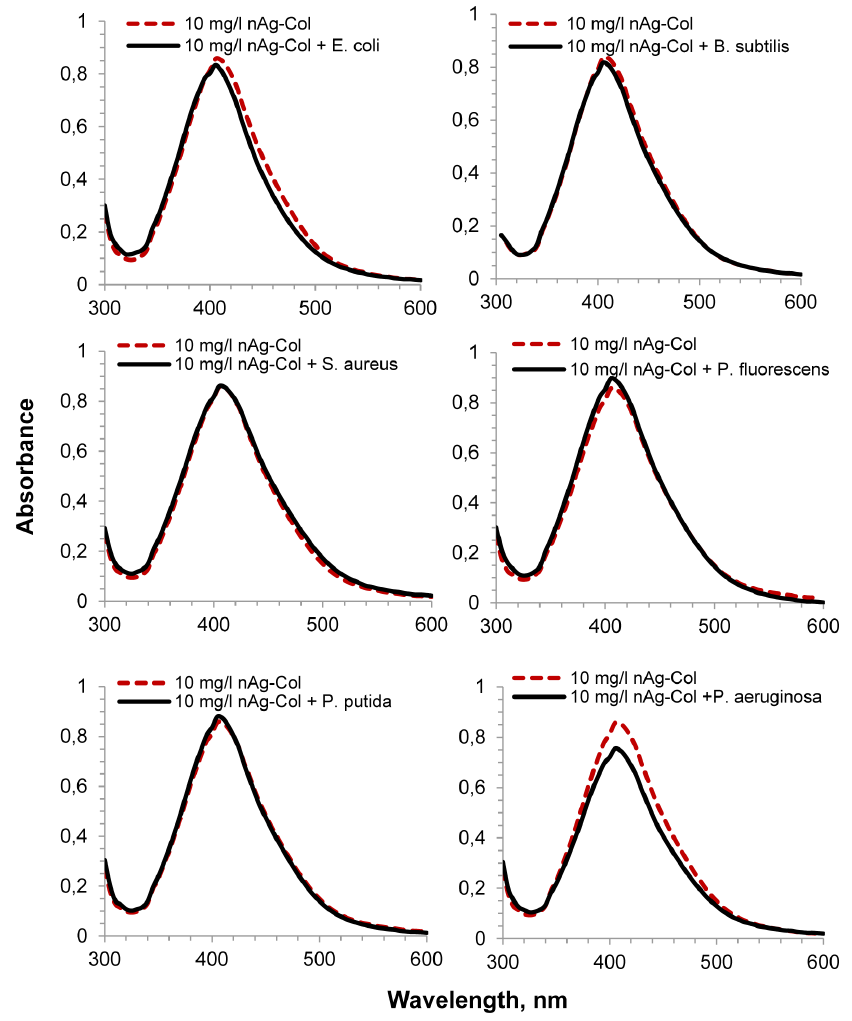
Figure 7. UV-visible absorption spectra of nAg-Col suspensions (10 mg Ag/l) with or without bacteria. UV-Vis spectra of AgNPs in half- strength NaCl-free LB medium without bacterial cells (dashed red line) or after exposure of bacterial cells to nAg-Col (solid line). Before measurement, bacterial cells and cell-associated nanoparticles were removed by centrifugation at 4 000 g for 5 minutes. The difference between dashed and continuous lines shows the co-precipitation of nAg-Col particles with bacterial cells. The representative figures from the three independent experiments are shown.